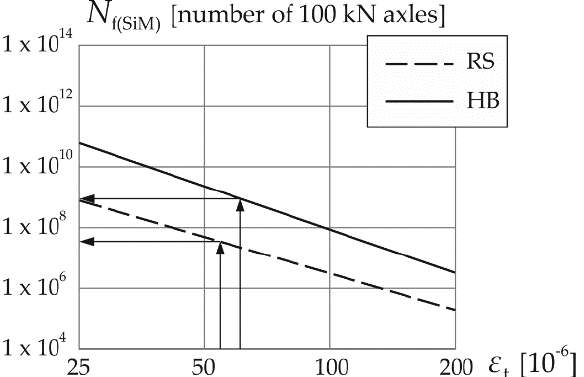
Figure 3. Fatigue curves of the entire structures with asphalt base course fatigue characteristics based on formula (1) and the SiM method; the resulting predictions of the pavement life for the critical strain values presented in Table 7 are marked.